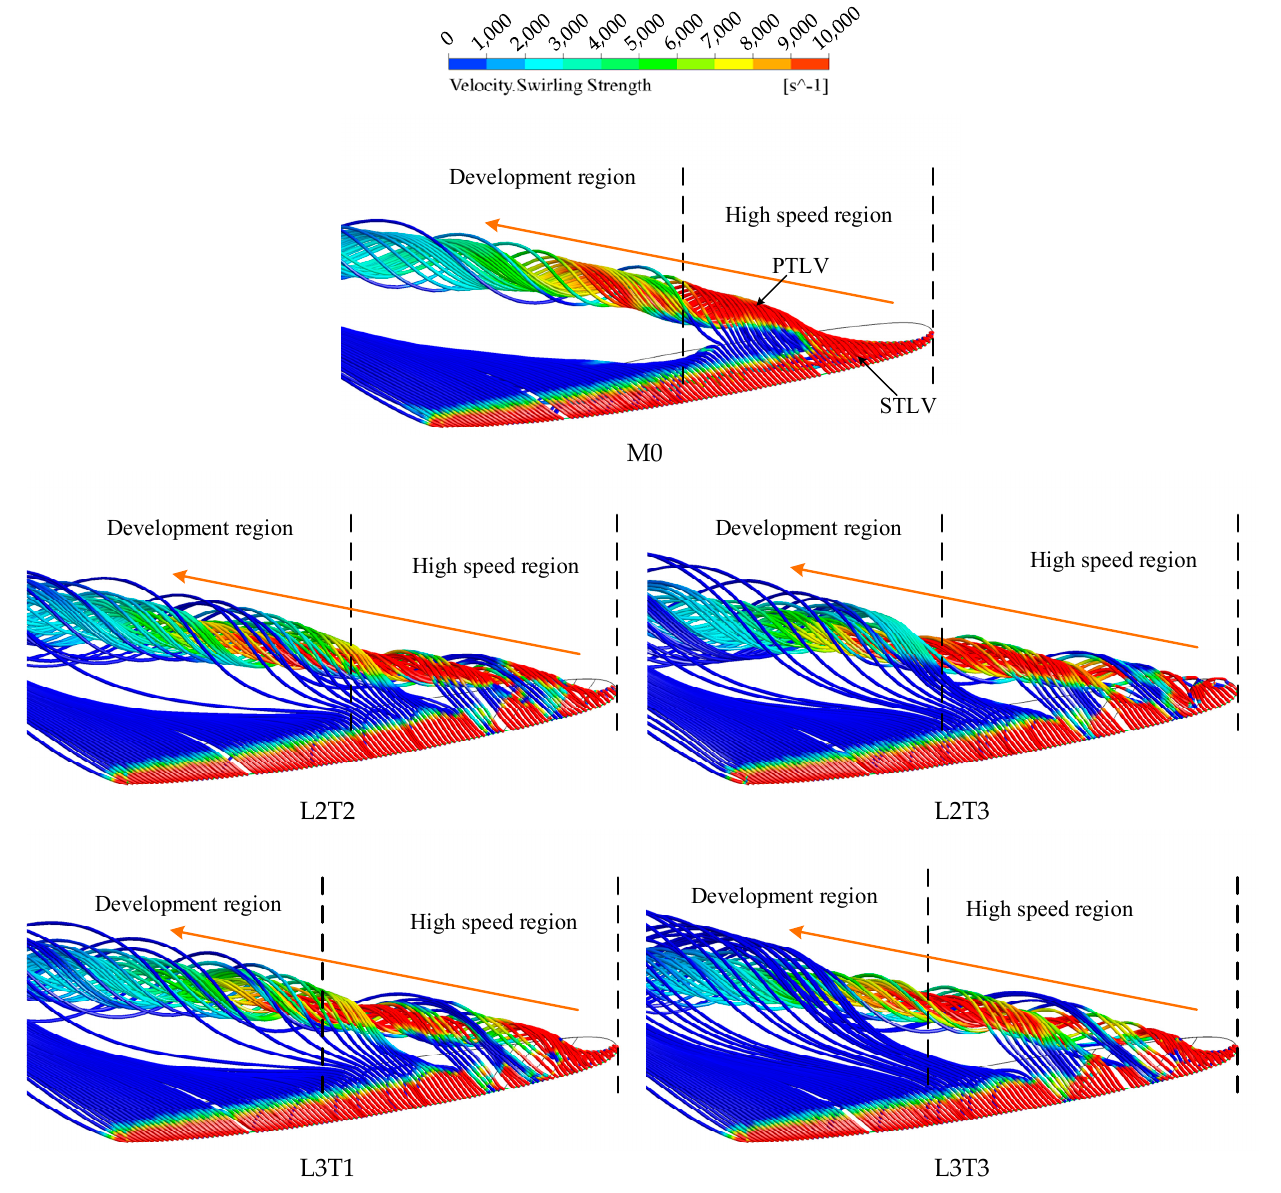
Figure 7. Three dimensional streamlines of different schemes. Additionally, the vortex intensity of PTLV and STLV with parallel grooves is remarkably reduced both around the hydrofoil and tip clearance. The trajectory of the PTLV in M0 is marked by the orange dashed line in the figure, and it can be seen from L2T2, L2T3, L3T1, and L3T3 that the position of the vortex core in each cross-section is not significantly shifted, and the presence of the parallel grooves does not change the trajectory of the PTLV, but expands the vortex range. It can be assumed that the presence of parallel grooves makes the structures of PTLV and STLV diverge, thus suppressing the TLV.